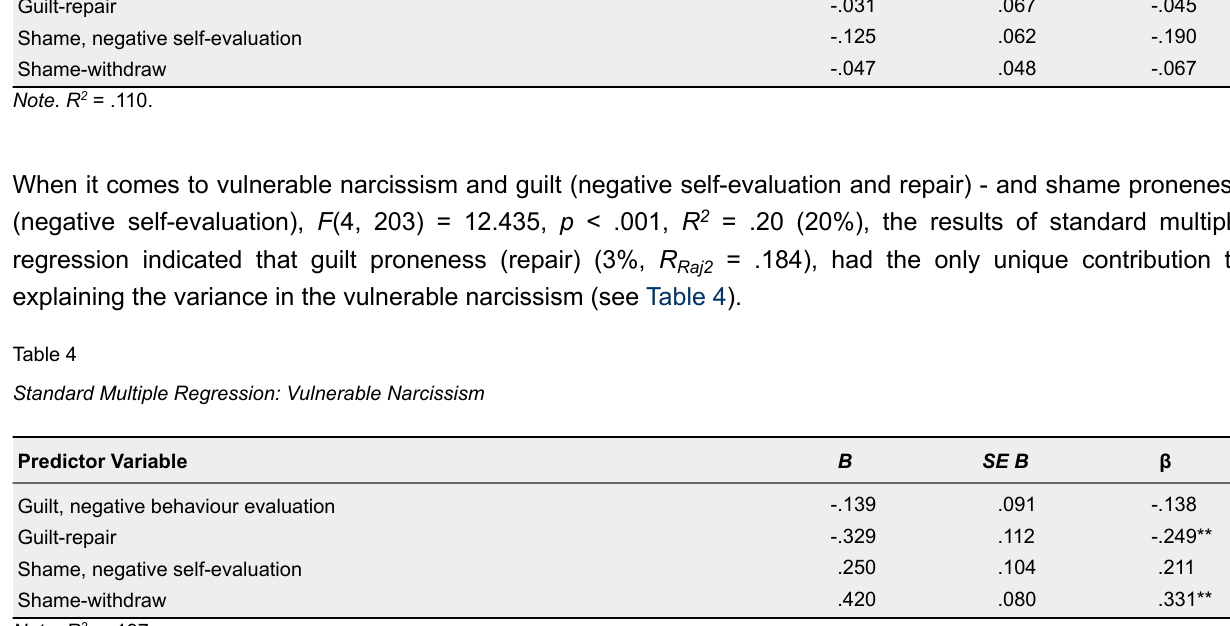
Standard Multiple Regression: Grandiose Narcissism Predictor Variable B SE B β Guilt, negative behaviour evaluation -.075 .054 -.134 Guilt-repair -.031 .067 -.045 Shame, negative self-evaluation -.125 .062 -.190 Shame-withdraw -.047 .048 -.067